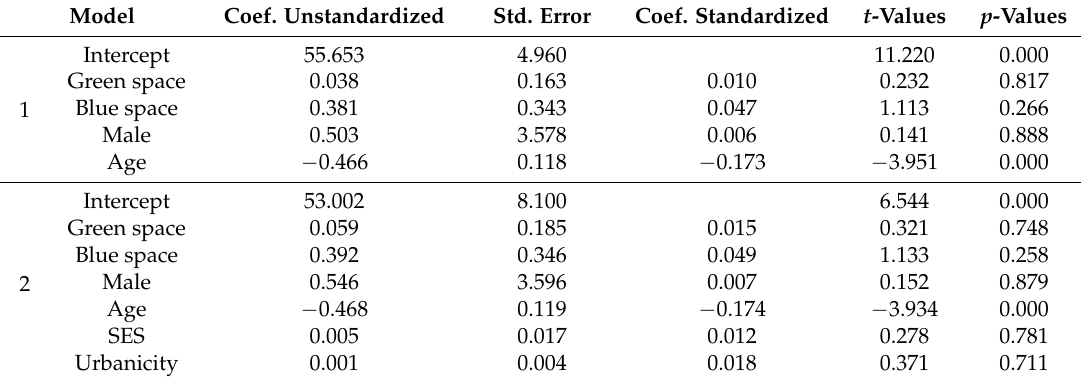
Table 3. Regression